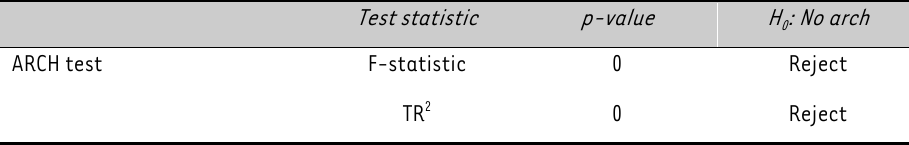
TABLE 2: ARCH test